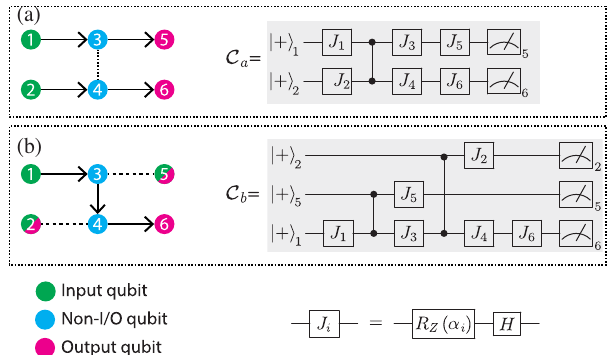
FIG. 2. Schematic representation of equivalent computations in MBQC (left) and in the circuit model (right). The underlying MBQC is based on a six-qubit H-shaped graph state with two different g-flows, consisting of (a) two and (b) three input/output qubits (other choices are possible). The direction of the flow is indicated by the arrows on the graph, with edges not involved in the flow shown as dashed lines. The qubits are measured according to the order of the labeling numbers. In panel (a), the input state of the circuit C a is j þ þi 12 , associated with qubits 1 and 2 of the cluster state, whereas in panel (b), the input state of the circuit C b is j þ þþi 251 , associated with qubits 1, 2, and 5 of the cluster state. The qubit ordering in the circuit is chosen according to the output labels, and the detailed procedure for going from the graph and flow to the circuit can be found in Appendix B. Note that both quantum circuits on the right correspond to the same MBQC graph state on the left, albeit ˆ J with a different flow. The basic single-qubit gate ð α i Þ ¼ ˆ H ˆ R ˆ J α i ¼ ð 1 ; … ; 6 Þ ] can be decomposed z ð i Þ [for brevity, i with ˆ H ˆ R α Þ around the z axis of into a Hadamard gate and a rotation z ð the Bloch